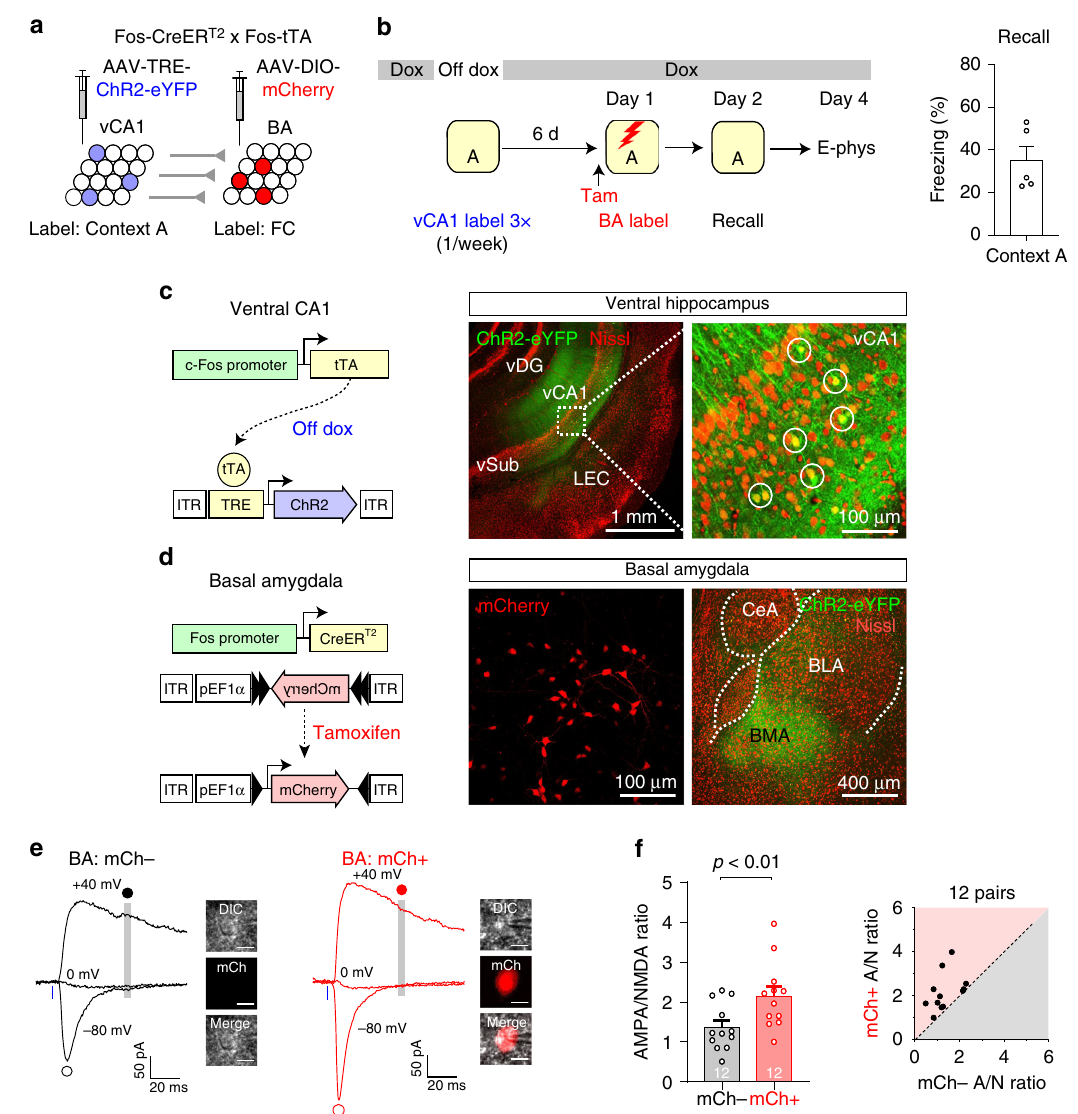
Fig. 7 Dual independent labeling revealed selective strengthening of synapses that connect context-speci fi c vCA1 neurons to BA fear neurons in contextual fear conditioning. a Experimental setup. b Left: mice were taken off Dox and exposed to Context A to induce ChR2 expression in Context A vCA1 neurons. Mice received two additional vCA1 labeling sessions with a 1-week interval (vCA1 label 3×). Mice were put back on Dox immediately after each context labeling session. After tamoxifen injection, the mice were fear-conditioned in Context A on Day 1 for mCherry expression in BA fear